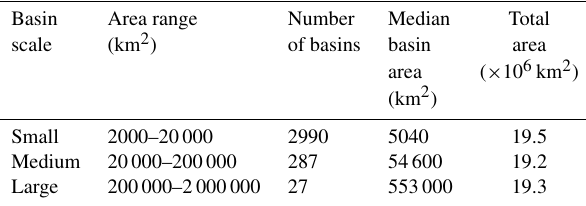
Table 2. List of principal basin scales used, showing information about the properties of the basins, based on all basins which are part of the HydroBASINS Asian domain (shown in Fig.